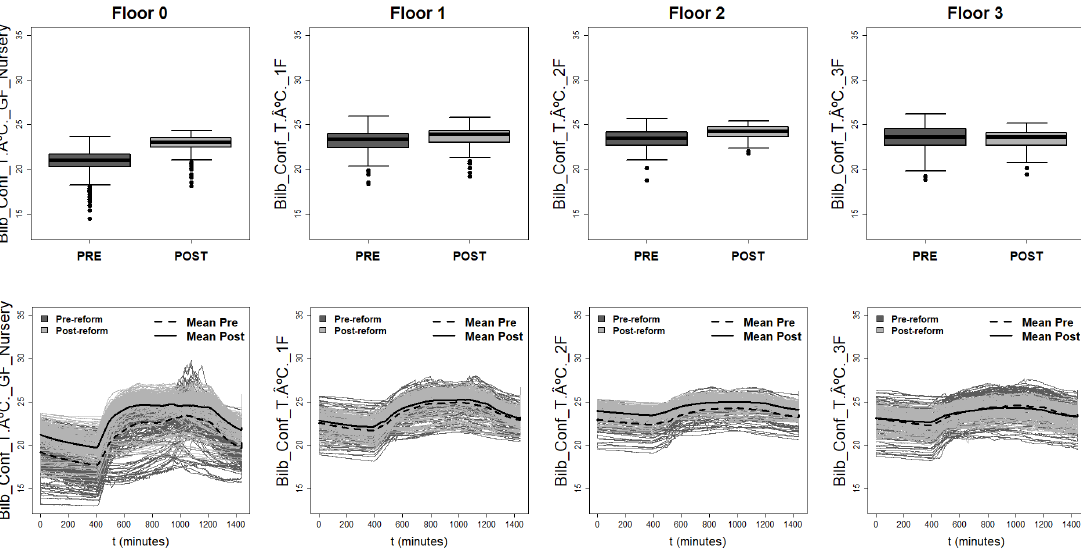
Figure 8. Analysis of the temperatures on each floor measured in ◦ C. In the first row, the vectorial results (in form of box plots) are presented. In the second row, instead, the functional data are represented with the respective mean functions. The data are divided into winter days before and after the